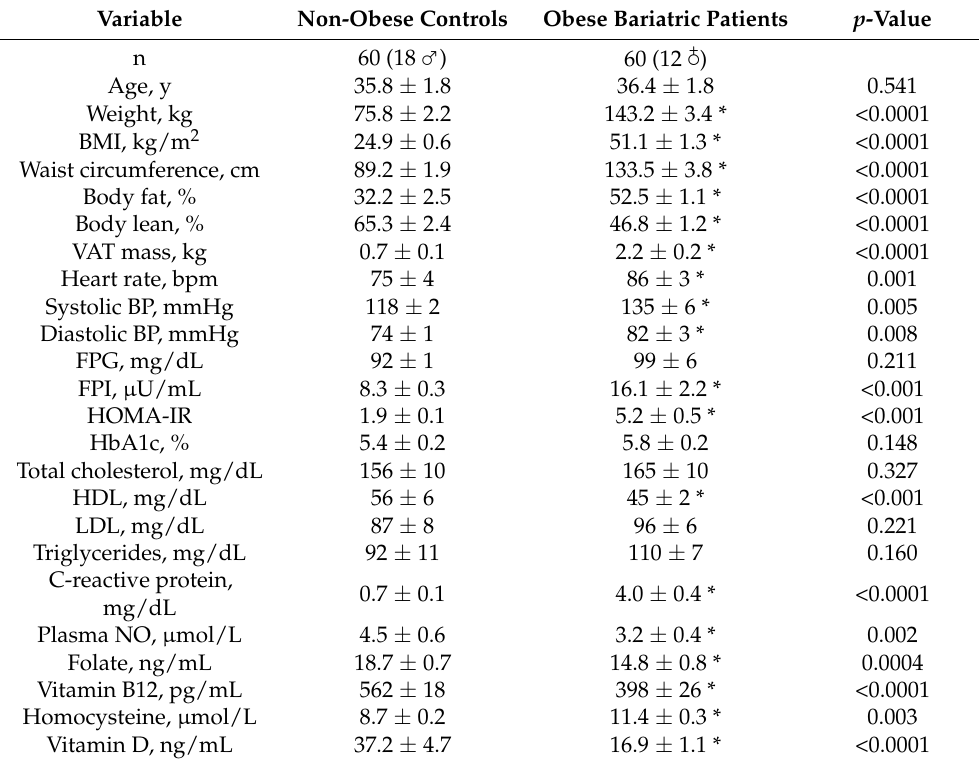
Table 1. Subject characteristics and cardiometabolic risk factors. Variable Non-Obese